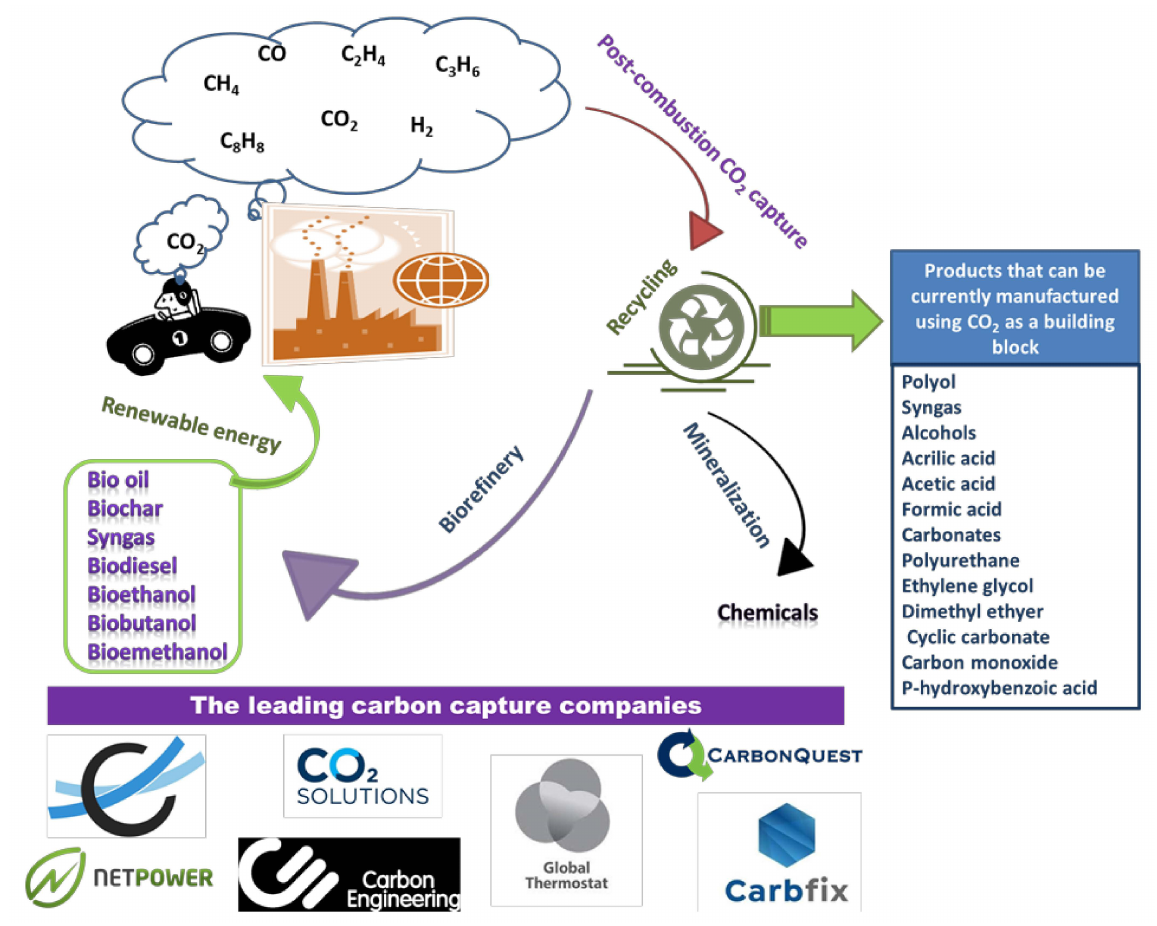
Figure 9. Schematic representation optimization of carbon circular and the leading companies in this